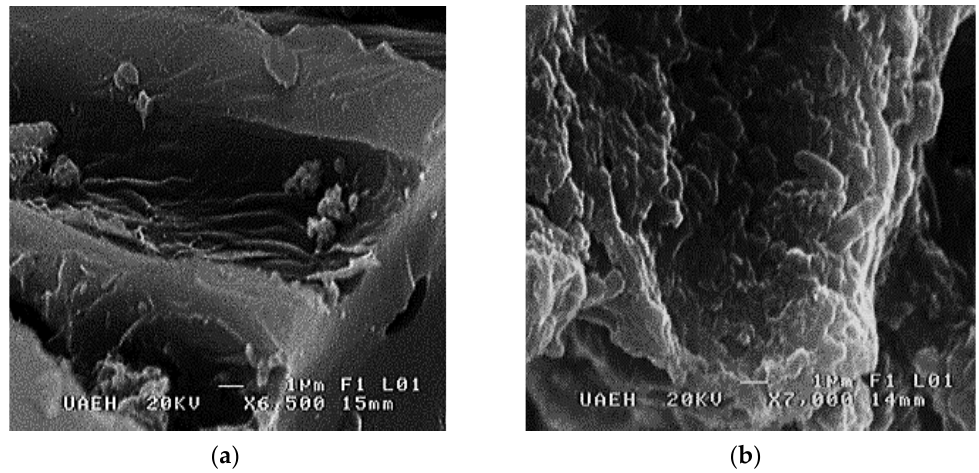
Figure 1. Micrograph of the whey microstructure: ( a ) without biofilm K.marxianus and ( b ) scanning of the optimal conditions for IA production in whey, time of 48 h K.marxianus biofilm formation.